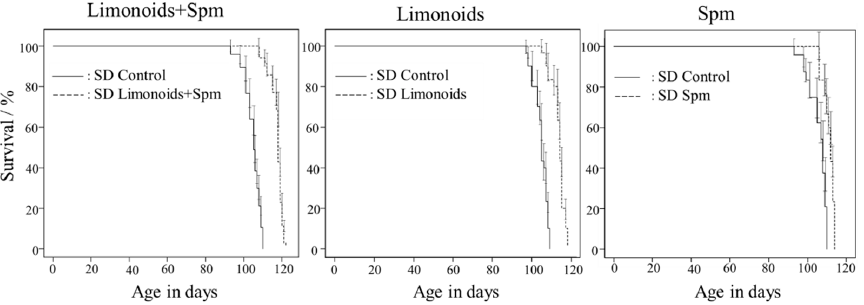
Figure 2. Survival curves for mice with Sandhoff disease fed with limonoids + Spm,